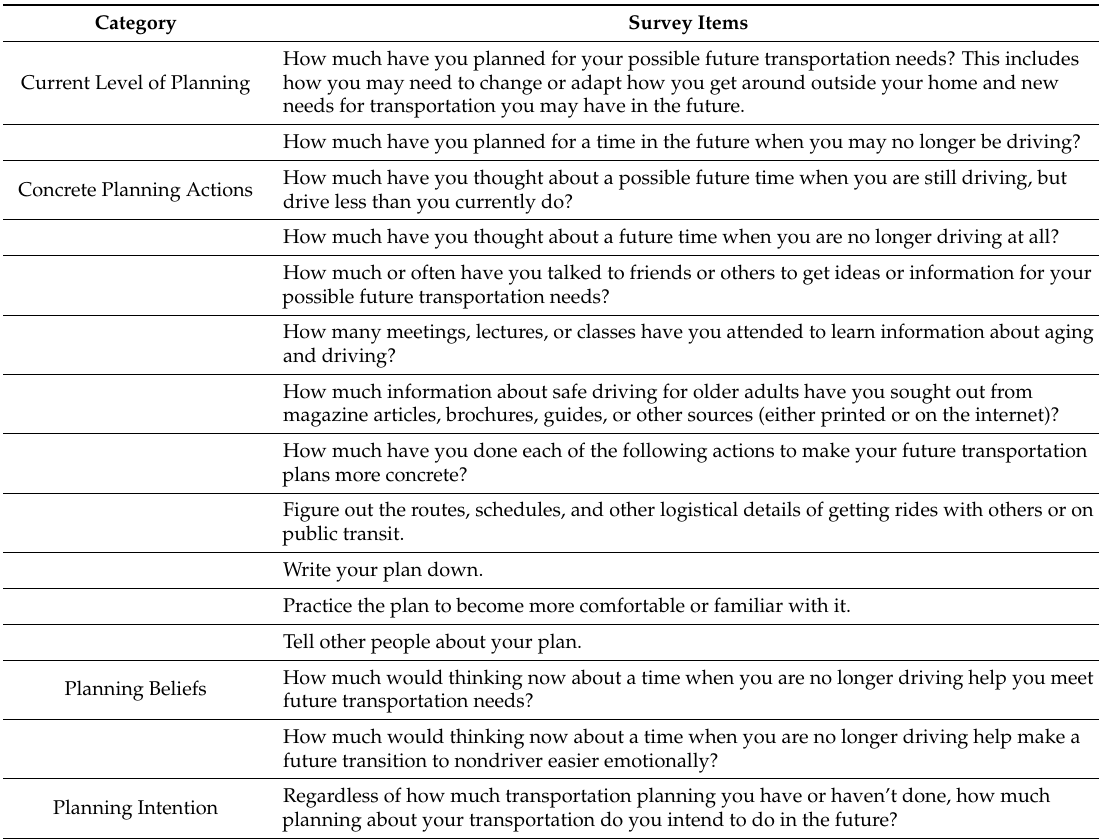
Table 1. Planning-Related